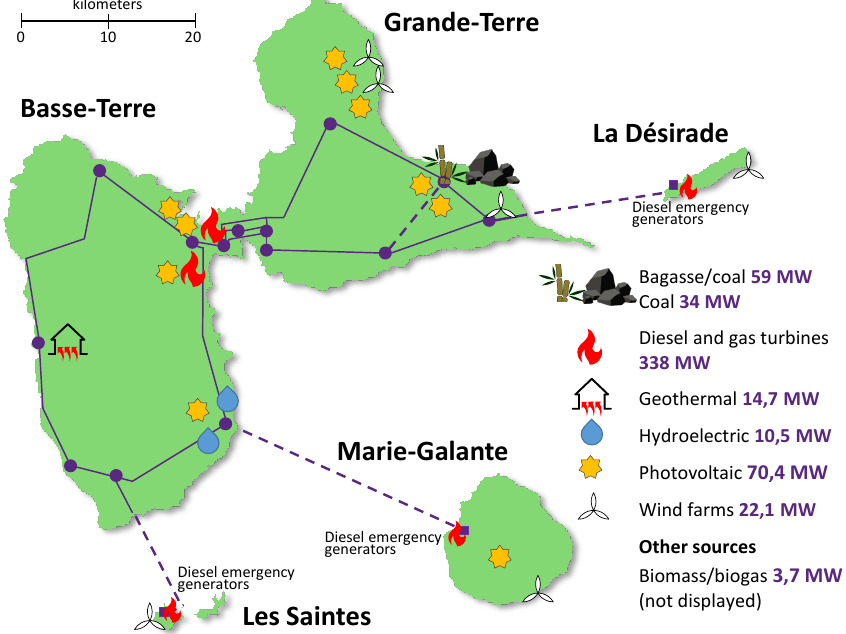
Figure 1. Available power in Guadeloupe’s power grid by type of primary energy in